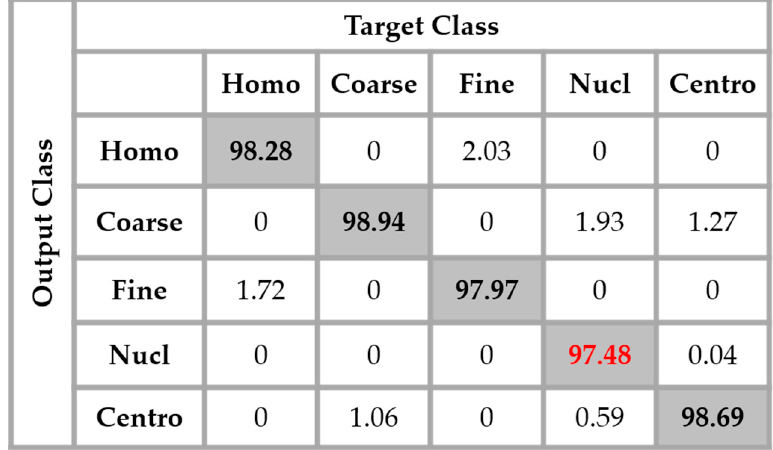
Figure 15. Confusion matrix of the results over the testing set by using the proposed dynamic learning with data augmentation. The total accuracy is 98.27%.